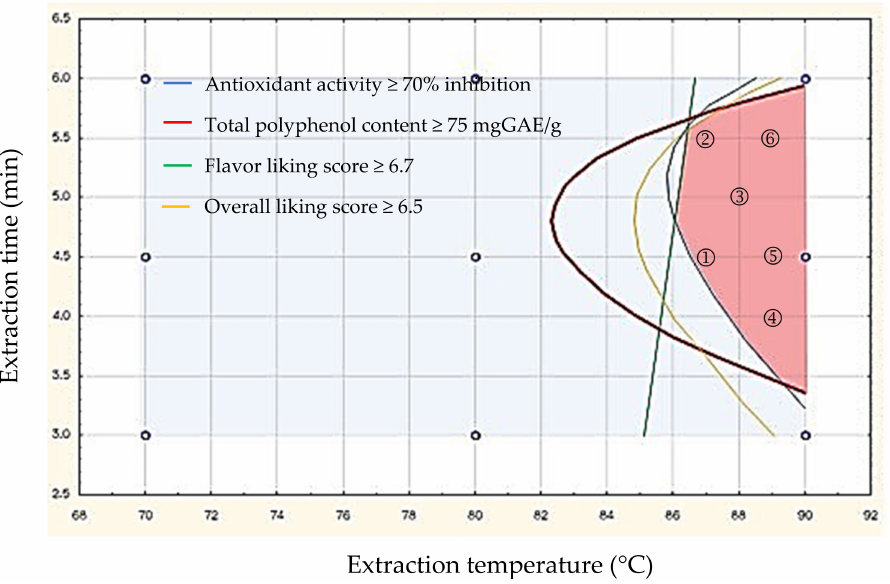
Figure 5. Overlaid contour plot showing the effect of the interaction of extraction temperature and time on antioxidant activity, total polyphenol content, flavor and overall liking score. Table 5. The verification tests of the fitted